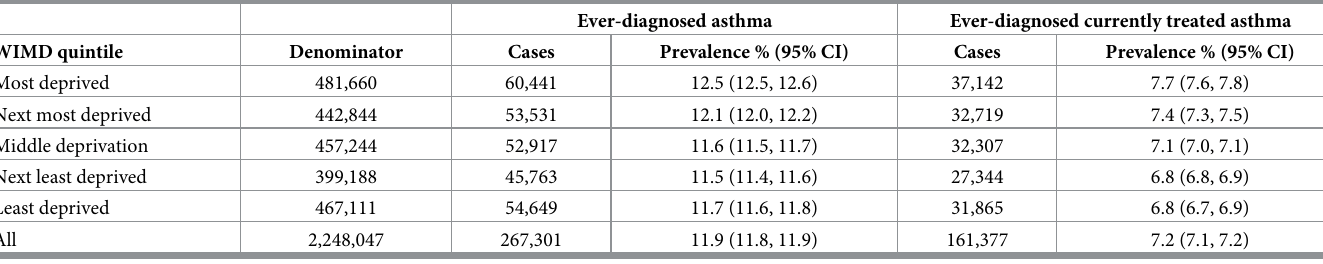
Table 1. Characteristics of the source population in 2013 across the WIMD 2011